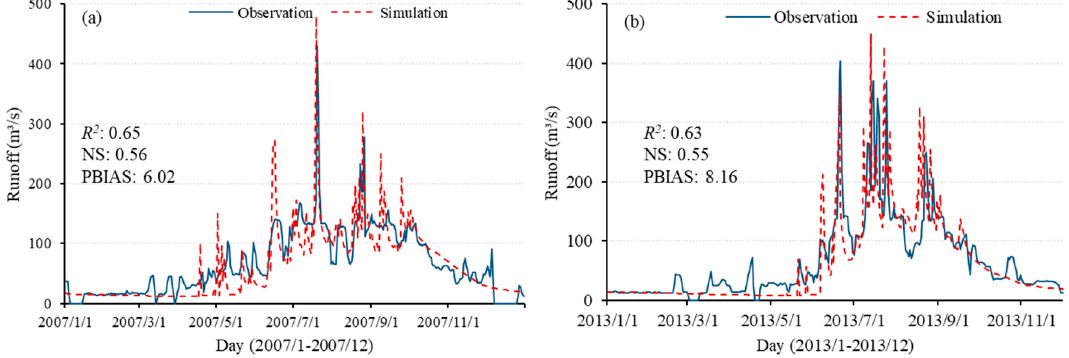
Figure 10. Daily observation and simulated runoff of Yingluoxia in 2007 ( a ) and 2013 ( b ).